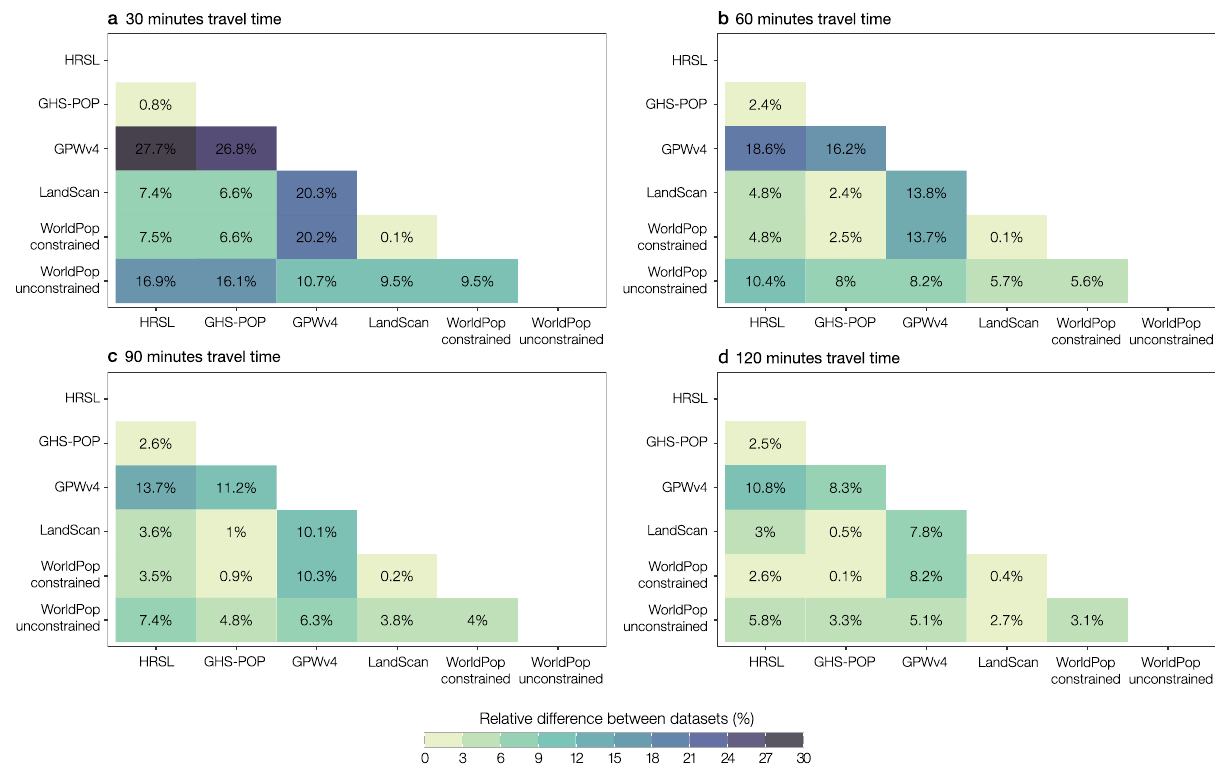
Fig. 2 Relative difference in accessibility coverage estimates. The matrix shows the relative difference in accessibility coverage statistics at a 30, b 60, c 90, and d 120 min travel time for the six gridded population datasets for the full Sub-Saharan African